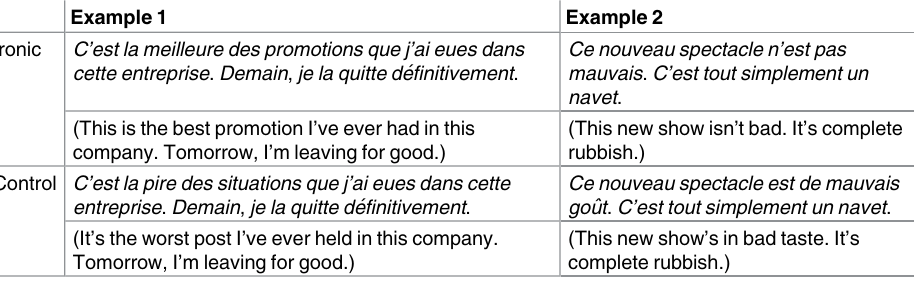
Table 1. Examples of the Two-Sentence